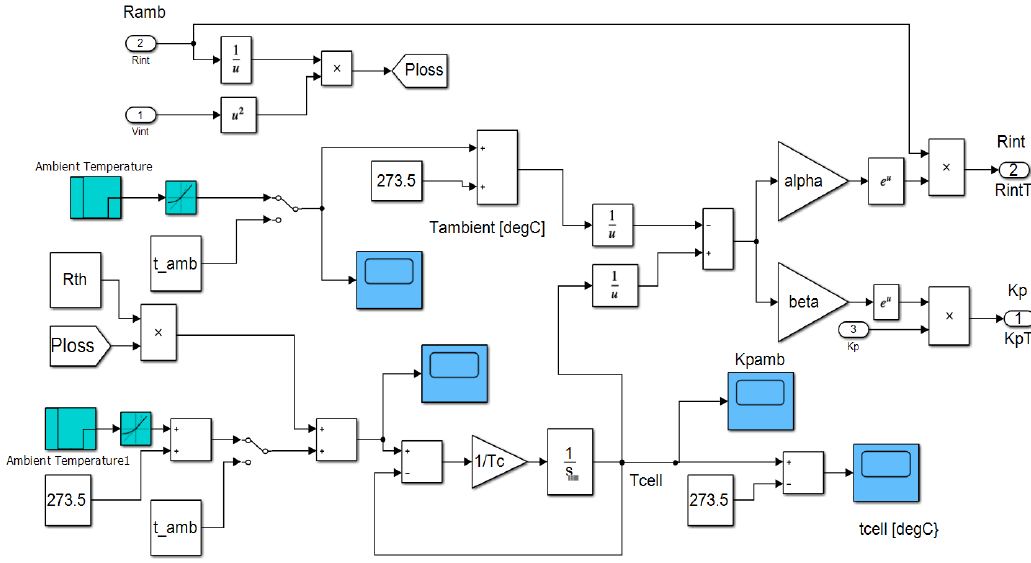
Figure 8. The detailed Simulink diagram of the Simulink Simscape thermal model block (see [14]).